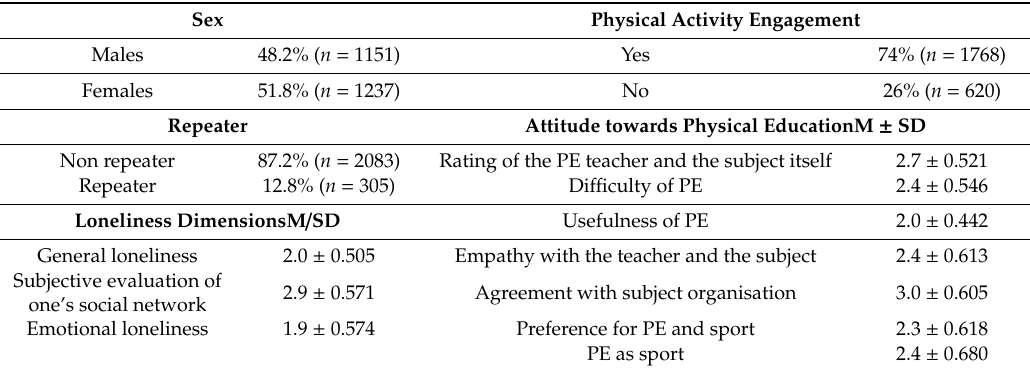
Table 1. Descriptive statistics of the study